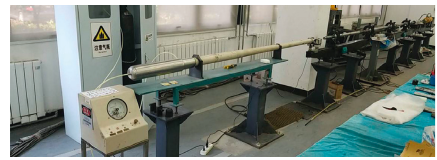
Figure 1: Split Hopkinson pressure bar testing